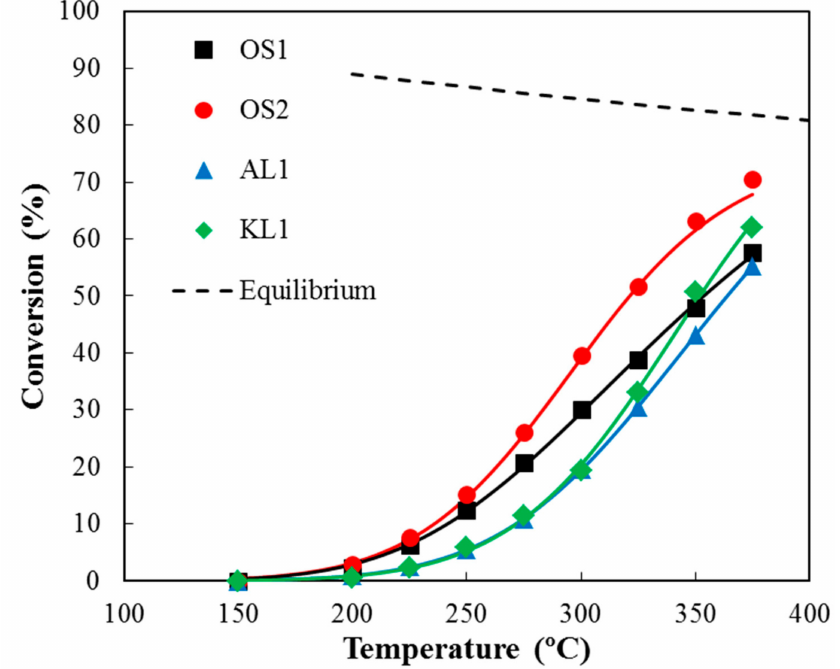
Figure 5. Methanol conversion as a function of the reaction temperature for the di ff erent carbon monoliths catalysts under air conditions. P MeOH = 0.03 atm, W / F MeOH = 0.1 g · s / µ mol. Dots: experimental data, lines: Langmuir-Hinshelwood model fitting; dash lines: equilibrium